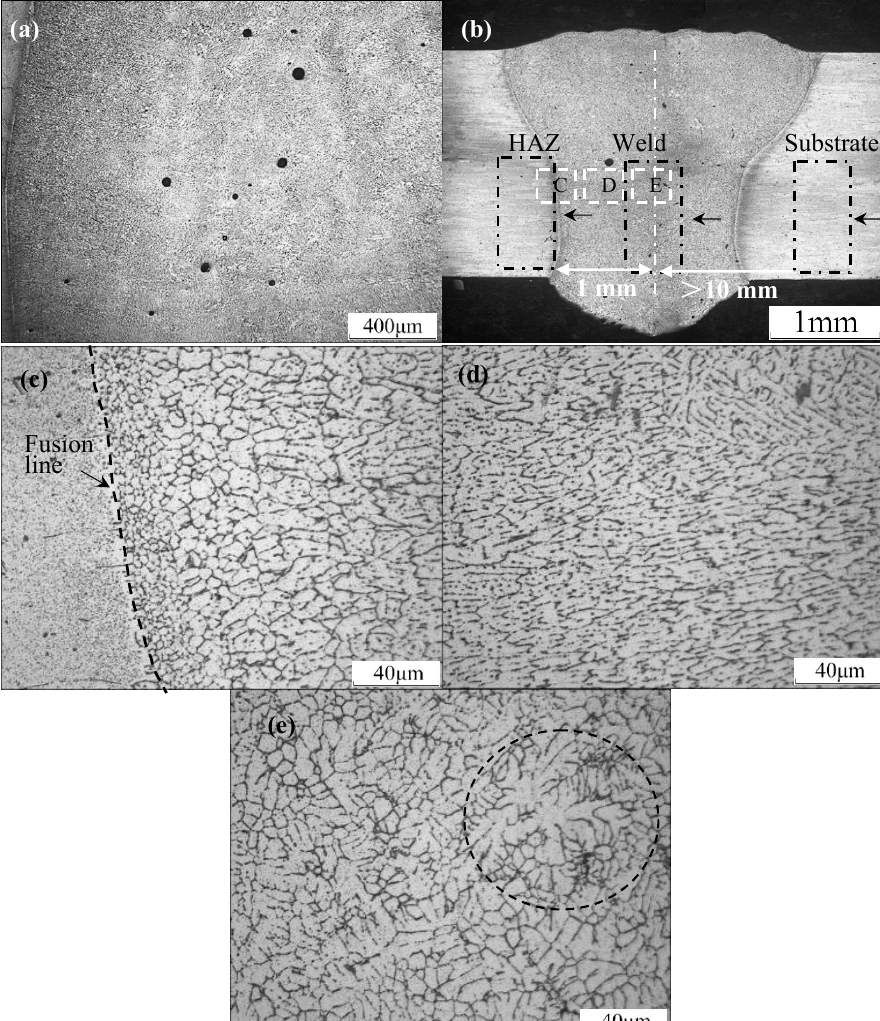
Figure 1. Optical microscopy images of different regions of 2060 Al–Li alloy laser welding joint. ( a ) pores in the top surface of the weld; ( b ) cross-section of the macro morphology of the weld; ( c ) regions of the fusion zone close to the fusion line; ( d ) regions of the fusion zone far from the fusion line; ( e ) central regions of the fusion zone (C, D and E in Figure 1b indicate the position of Figure